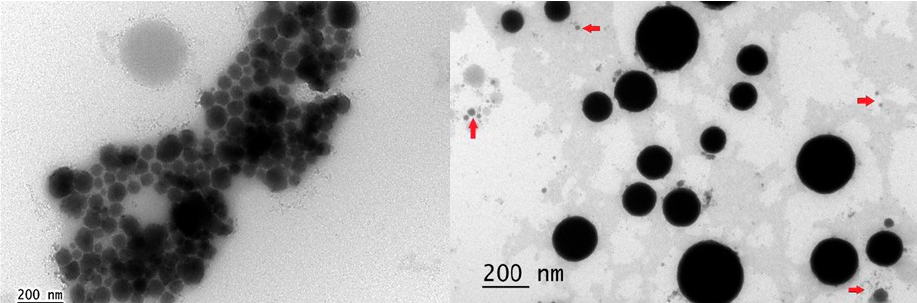
Figure 6. Transmission electron microscopy (TEM) morphology of the micelles in the nanoemulsion of the Cedrela odorata essential oil. The red arrows show the predominant droplet diameter in the DLS analysis at day 30 in samples stored at 5 ± 2 °C.